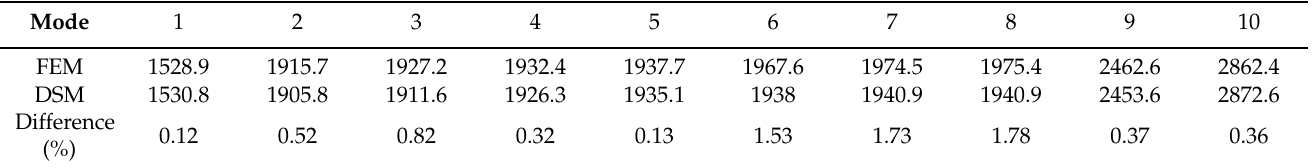
Table 6. Natural Frequencies, ω ( rad / s ) of Timoshenko beam Analysis with Hinged ends in Topology 1, original